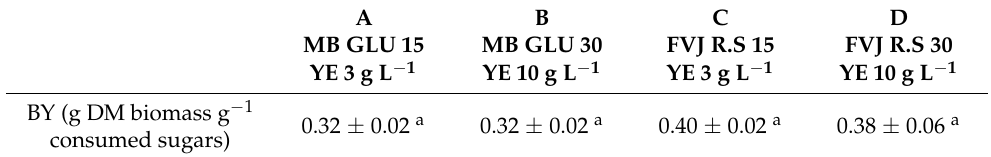
Table 5. E ff ect of nutrient composition in biomass yield during Fed-batch bo tt le trials. Table 5. Effect of nutrient composition in biomass yield during Fed-batch bottle trials. A MB GLU 15 BY (g DM biomass g − 1 YE 3 g L − 1 consumed sugars) BY (g DM biomass g − 1 0.32 ± 0.02 a 0.32 ± 0.02 a 0.40 ± 0.02 a 0.38 ± 0.06 a consumed sugars) con fi dence; values are expressed as means ± SD (n = 3).